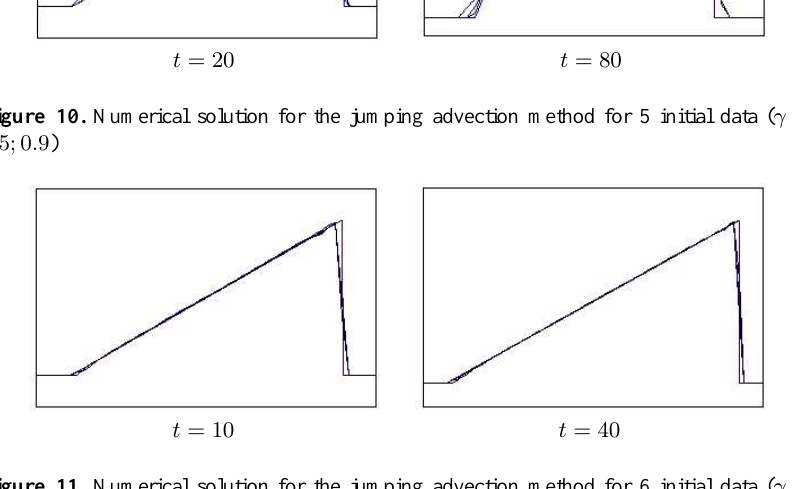
Figure 11. Numerical solution for the jumping advection method for 6 initial data ( (cid:13) = 0 : 5; 0 : 9